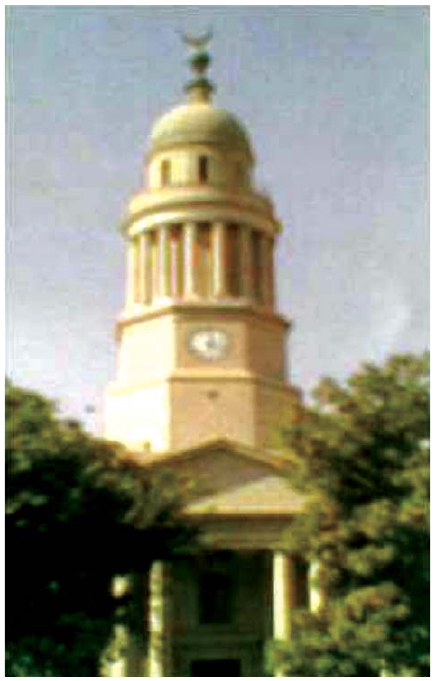
Fig. 2. Faculty of